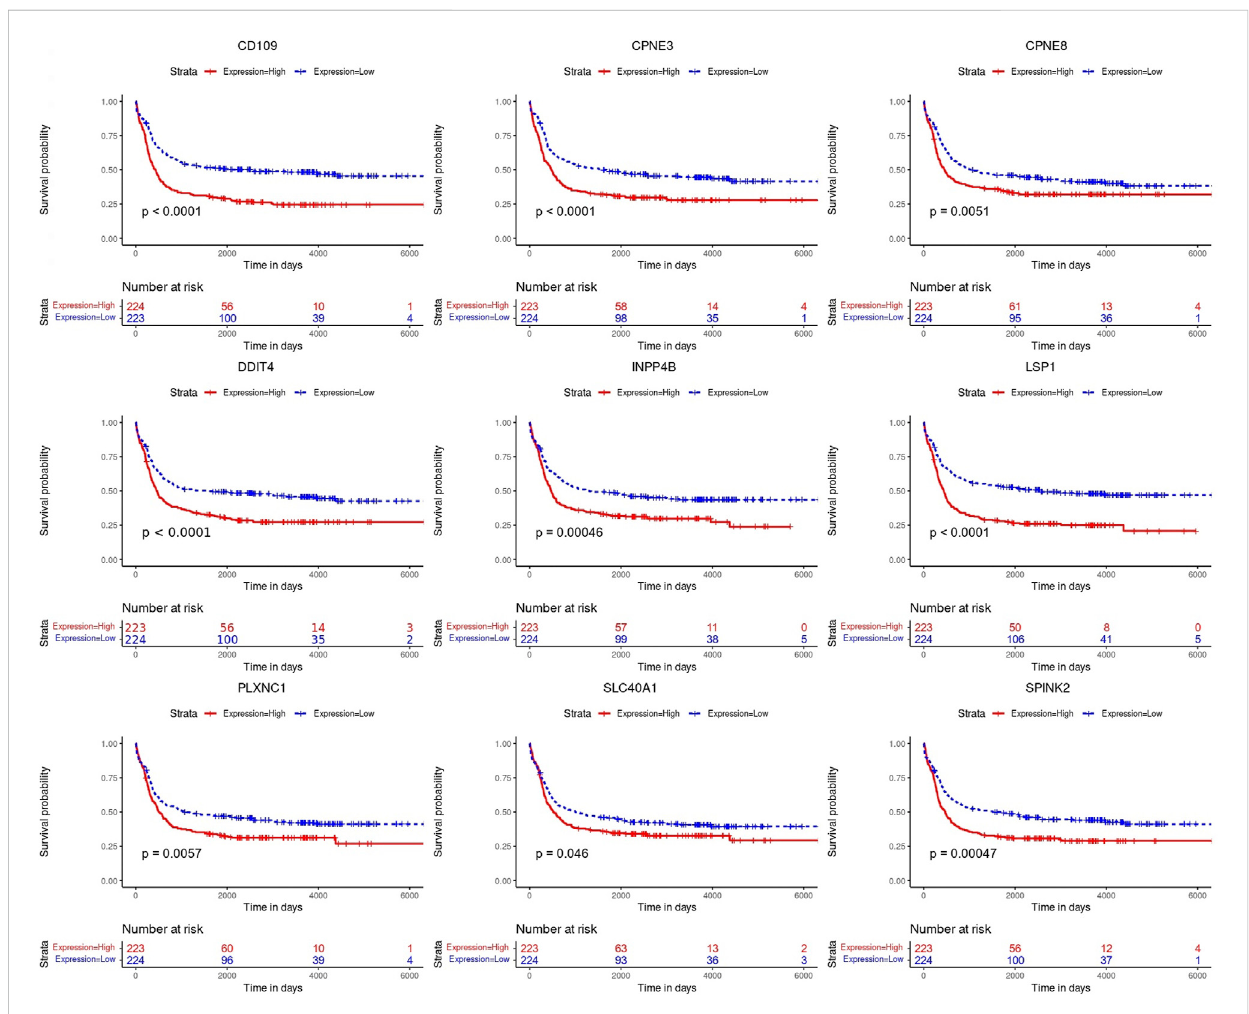
FIGURE 2 Kaplan-Meier(K-M)survivalcurves.Analysisrevealedthesurvivalpredictionassociatedwithhighandlowgeneexpressionpro fi lesoftheprognostic genes in AML patients.